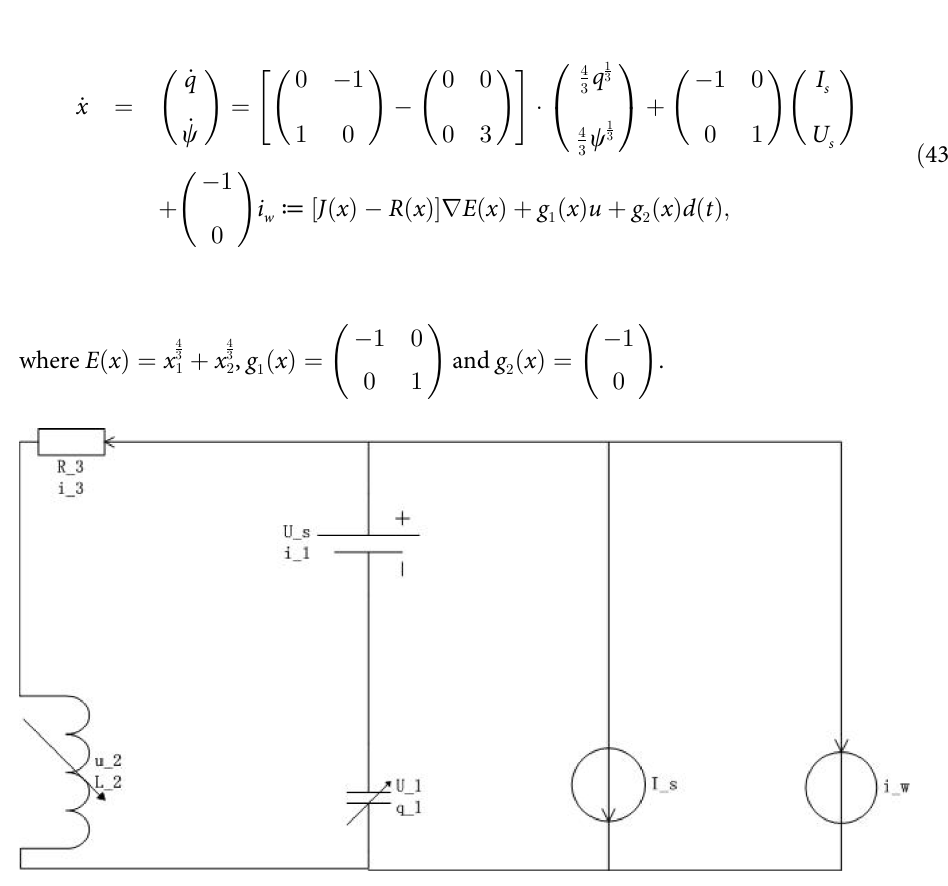
Fig 4. Nonlinear circuit system.